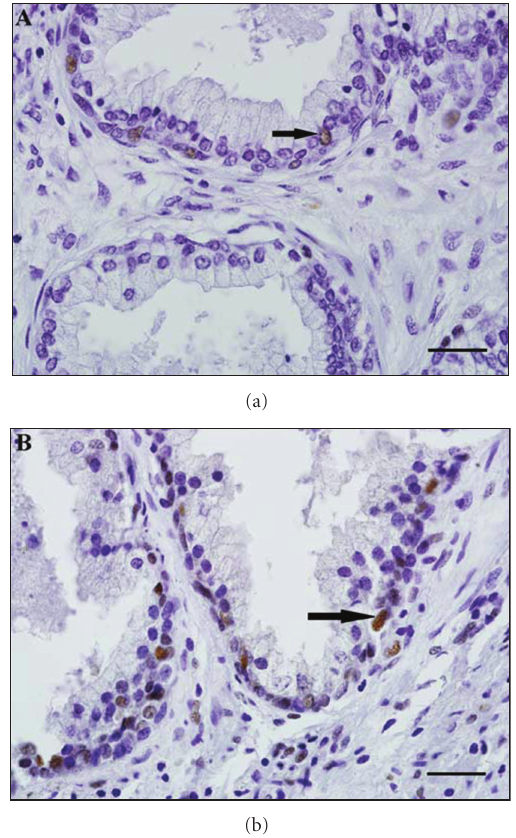
Figure 4: Photomicrography showing immunohistochemistry of PCNA, in the human hyperplasic prostate tissue after leptin treat- ment, 50ng/mL, (Leptin) or not (Control) for 3 hours. Magnifica- tion of